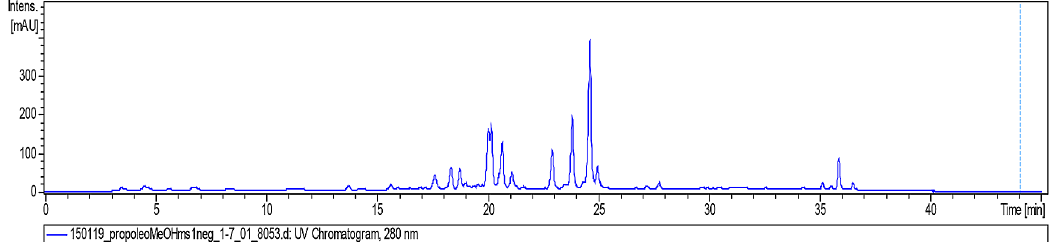
Figure 6. Analysis of the methanolic fraction of Oxapampa propolis by liquid chromatography coupled to mass spectrometry in positive